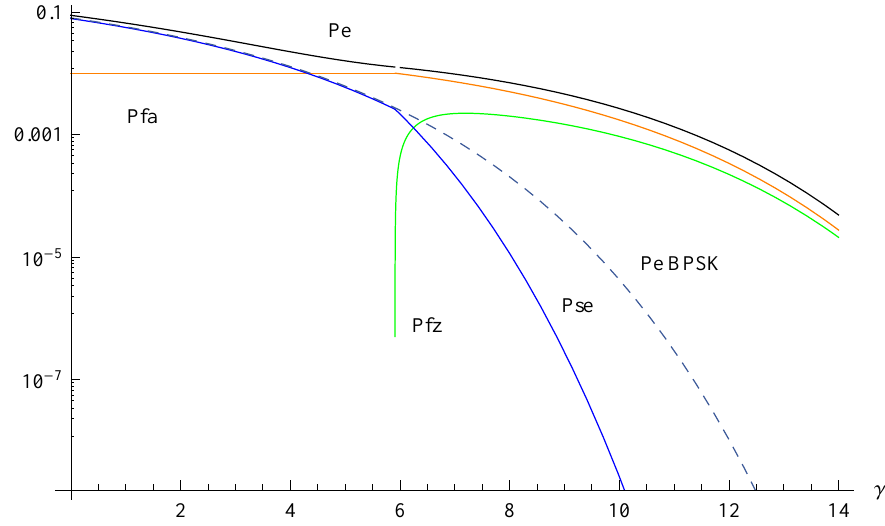
Figure 1. Error probabilities of the Z-binary phase shift keying (BPSK) and BPSK for P 0 = 0.01 as a function of the SNR γ = E s / N 0 .